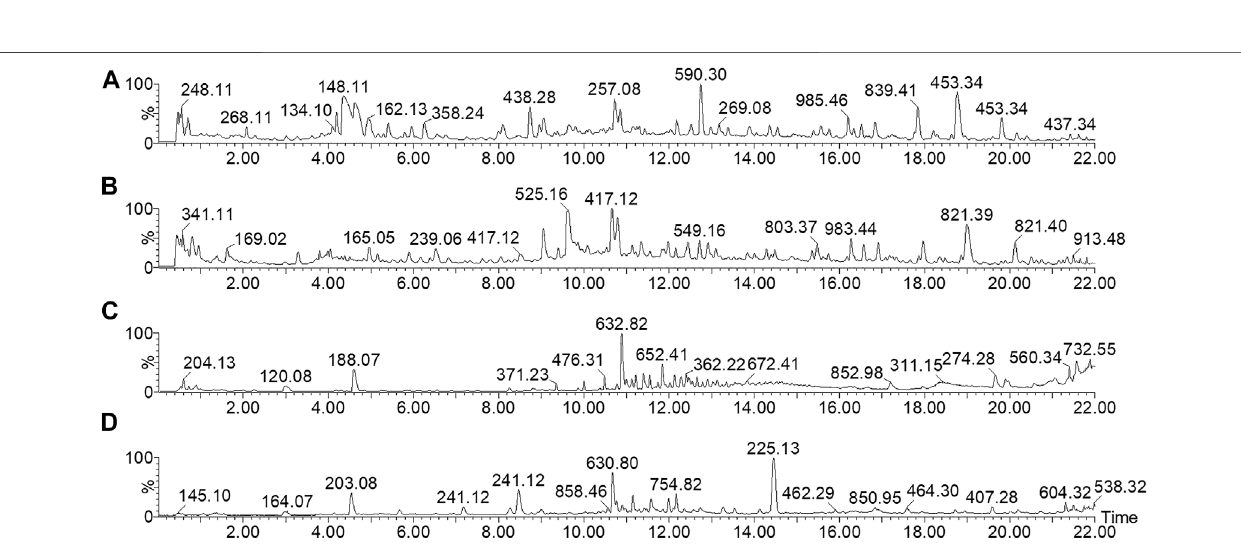
Frontiers in Pharmacology |